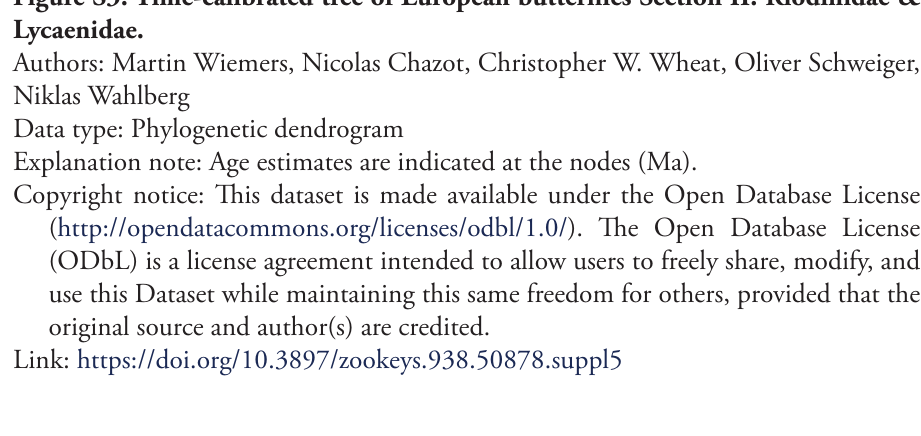
Figure S3. Time-calibrated tree of European butterflies Section II. Riodinidae & Lycaenidae.